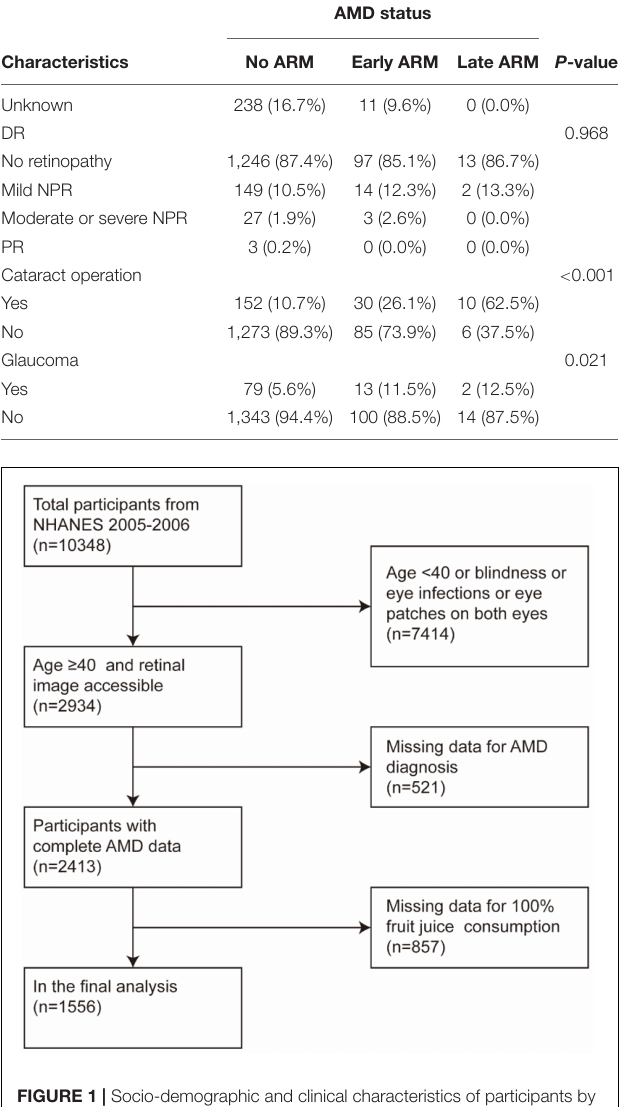
FIGURE 1 | Socio-demographic and clinical characteristics of participants by age-related macular degeneration (AMD)